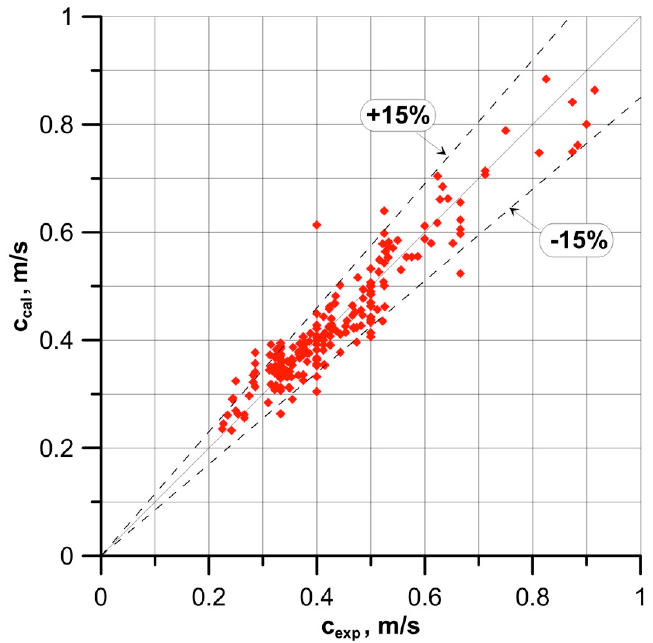
Figure 11. Comparison of measured and calculated values of wave velocity accompanying two-phase gas-very viscous liquid flow for relation (15).